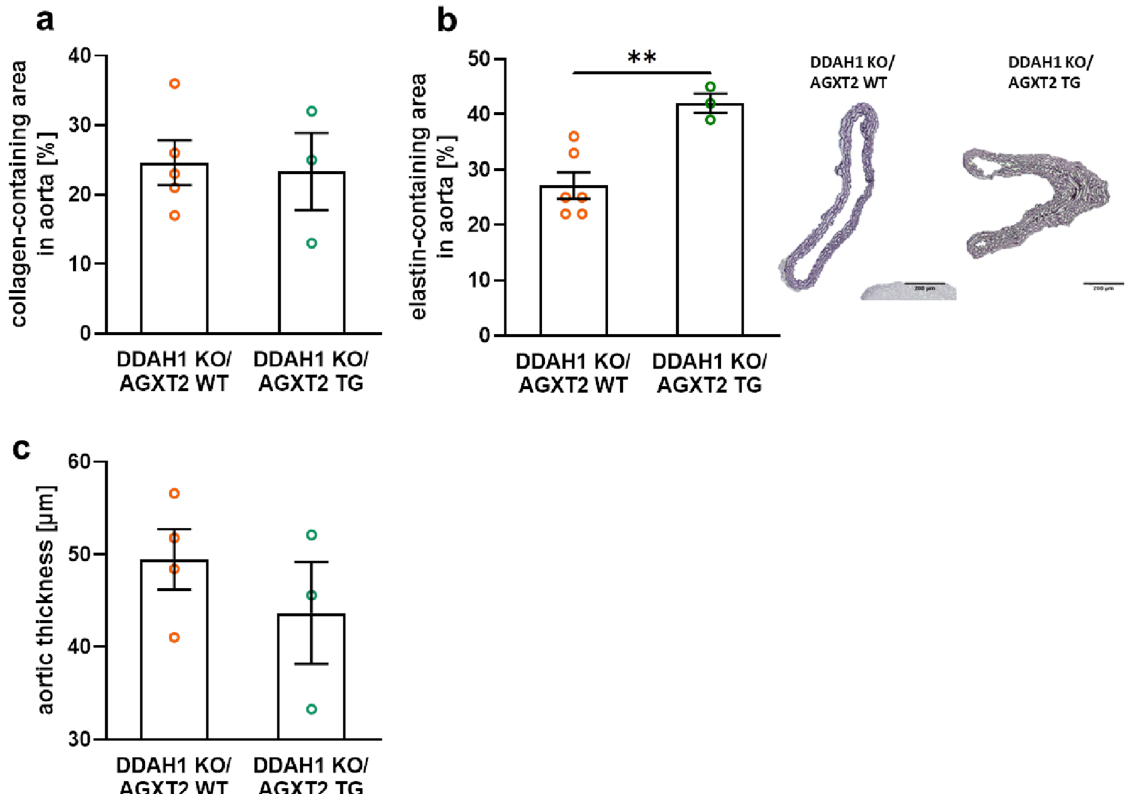
Figure 8. Collagen- ( a ) and elastin-containing areas in aorta ( b ) and aortic thickness ( c ) in DDAH1 KO/ AGXT2 WT and DDAH1 KO/AGXT2 TG mice. One-way ANOVA flowed by Tukey’s multiple comparison test, **p < 0.01. N = 3–6. Cohen’s d = 3.1